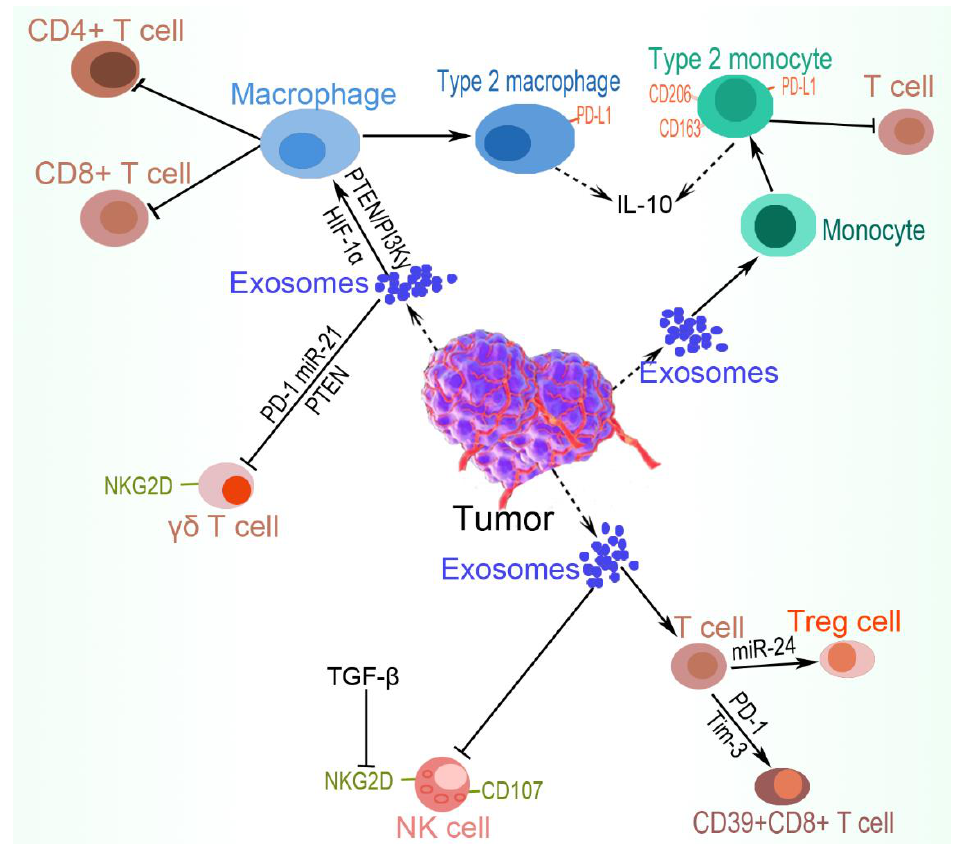
Figure 4. Tumor cell immune evasion via the suppression of immune cells. Tumor cells avoid im- mune surveillance by deactivating antigen-presenting cells, such as NK cells, via inhibiting their surface molecules, such as NKG2D and CD107, and polarizing macrophages and monocytes into tumor-promoting M2 phenotype. Cytotoxic T cells are deactivated or induced to differentiate into Tregs, in addition to expressing certain tumor immune evasion surface recognition molecules. Moreover, the unique T lymphocyte subtype γδ T cells are deactivated via the inhibition of surface molecules, such as NKG2D and exosomal transfer of PD-1, PTEN, and miR-21. The resultant